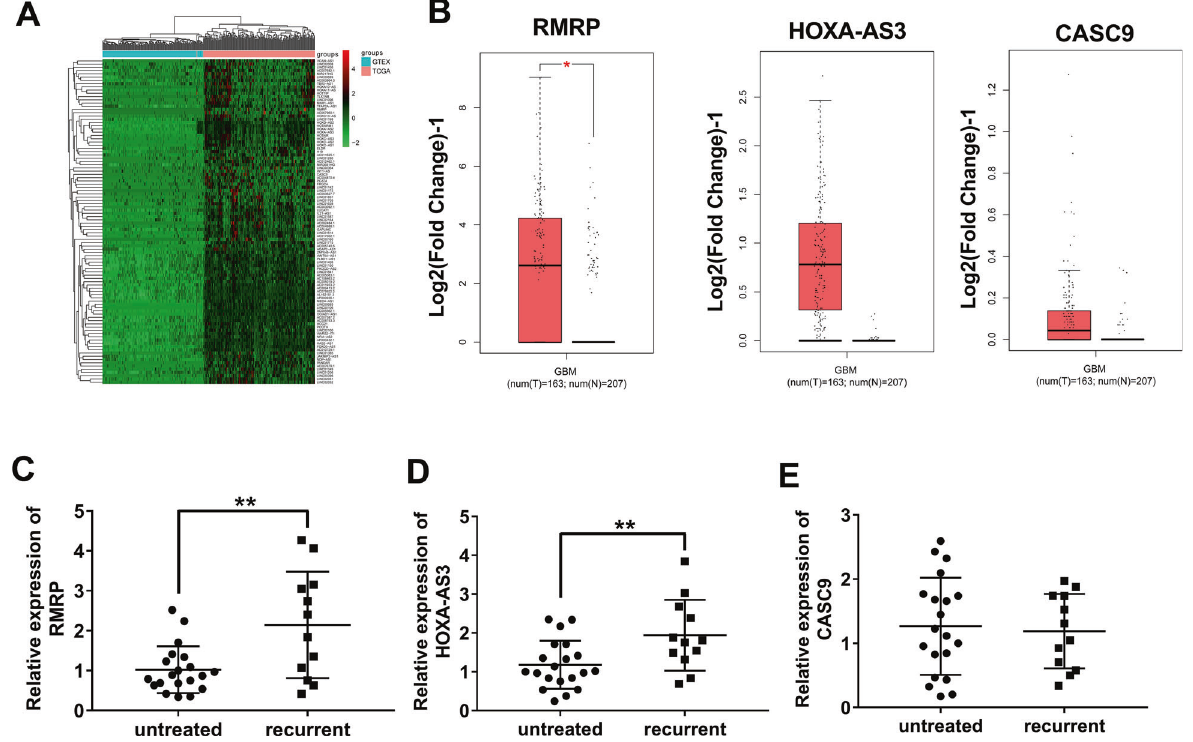
Fig. 1 Expression pro fi le analysis of lncRNAs in glioma and screening of interested lncRNAs. A The top 100 up-regulated lncRNAs in glioma versus normal brain tissues. B Expression analyses of 3 lncRNAs (RMRP, HOXA-AS3, and CASC9) in glioma versus normal tissues in the GEPIA database. C Expression levels of RMRP, HOXA-AS3, CASC9 in tumor tissues isolated from patients with recurrent glioma ( n = 12) and glioma patients without any treatment ( n = 20) were measured through RT-qPCR assay. * P < 0.05. ** P <